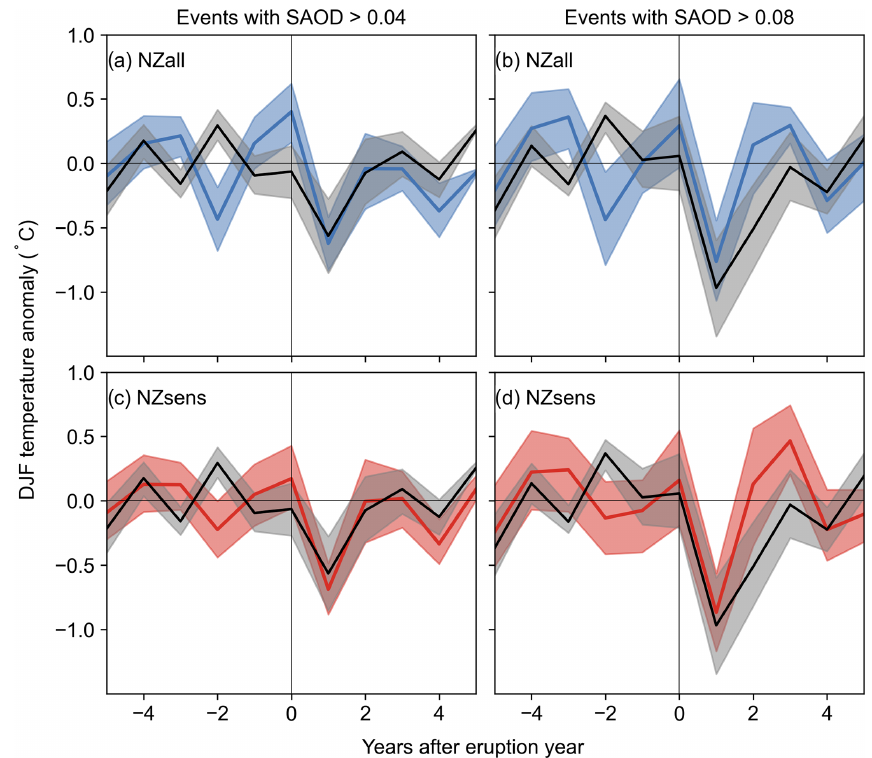
Figure 6. Mean anomalies 5 years before and after 21 eruption years with SAOD > 0.04 (a, c) and 13 eruption years with SAOD > 0.08 (b, d) for both the NZall (blue) and NZsens (red) reconstructions. The mean response from an ensemble of seven climate models to the same set of events is shown in black. The 90th percentile bootstrap confidence intervals were constructed from 1000 replicates of either 15 or 9 event years at random.